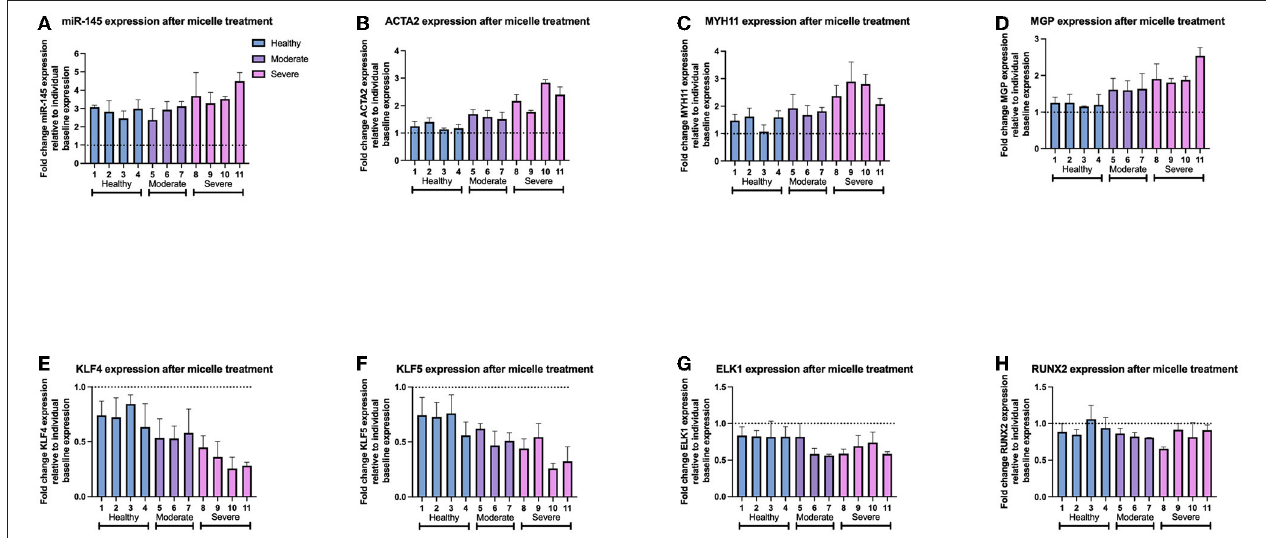
FIGURE 6 | Gene expression of individual patient-derived VSMCs after miR-145 micelle therapy for (A) miR-145 levels, (B) ACTA2, (C) MYH11, (D) MGP, (E) KLF4, (F) KLF5, (G) ELK1, and (H) RUNX2. Dotted line represents individual sample baseline gene expression.